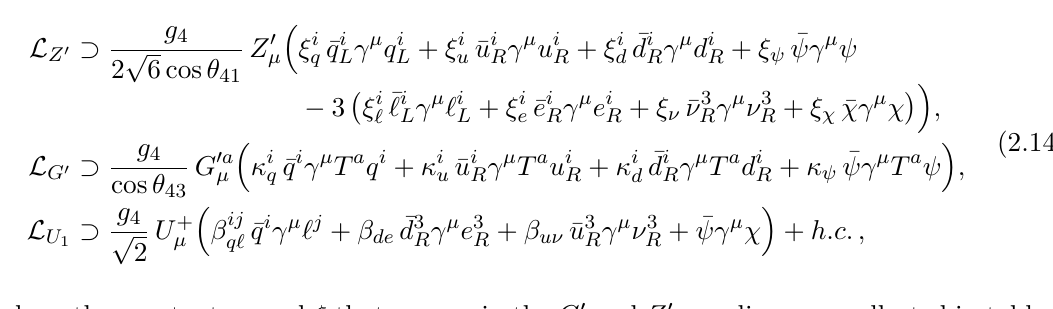
In this basis, the couplings of the new vector bosons U and to the DM-sector